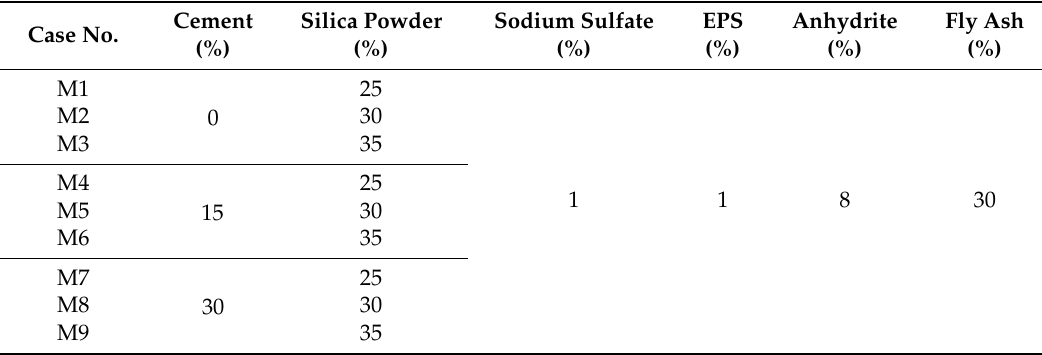
Table 1. Replacement ratio for each